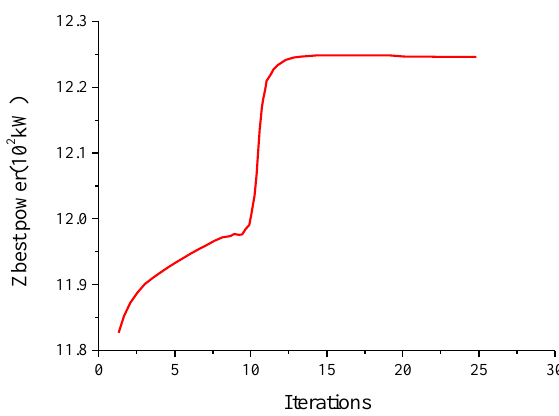
Figure 22. Evolution of the particle swarm under actual sea conditions.